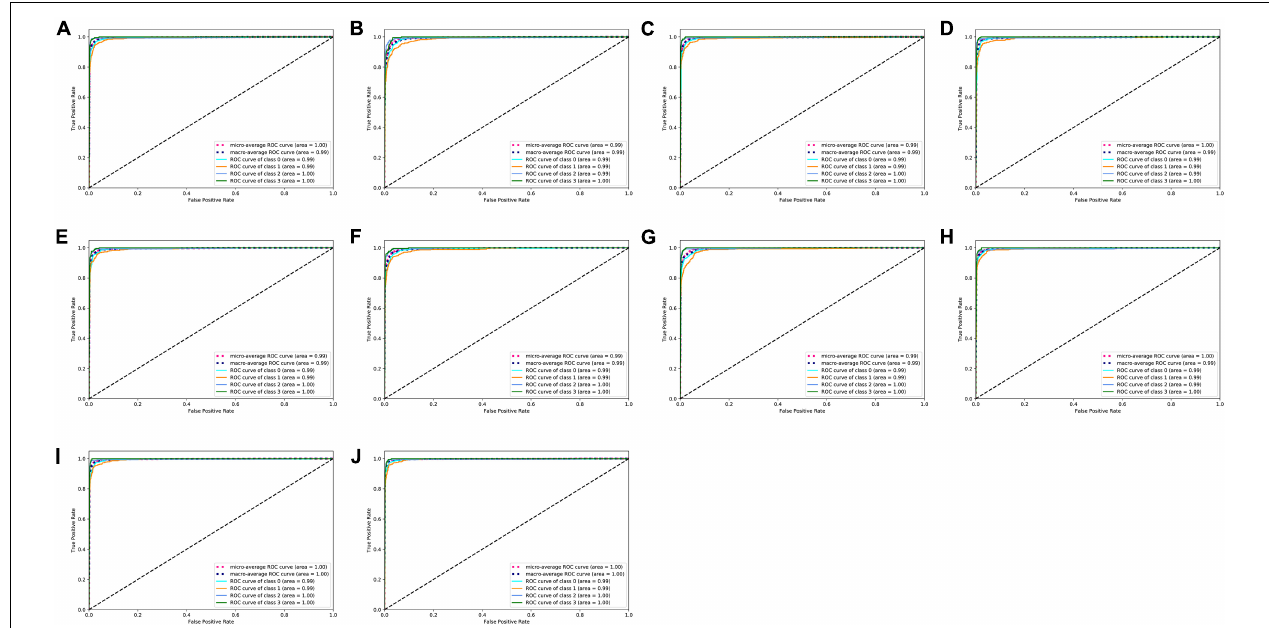
FIGURE 3 | ROC curves of ten deep learning-based models. (A–J) ROC curves of ResNet18, ResNet34, ResNet18_vd, ResNet34_vd, ResNet50_vd, ResNet50_vc, SE_ResNet18_vd, VGG11, VGG13, and VGG16 models to classify types of ventilatory patterns, respectively. Class 0 = normal; Class 1 = obstruction; Class 2 = restriction; Class 3 = mixed; ROC = receiver operating